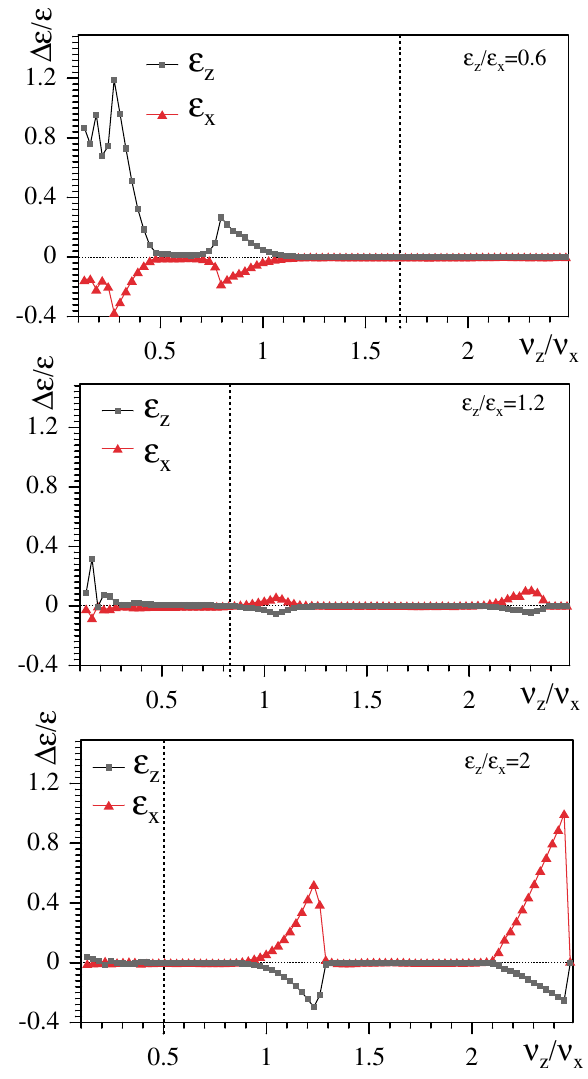
FIG. 9. (Color) Simulation results for WB beams, with (cid:3) 0 : 5 and (cid:19) (cid:3) 0 : 6 , 1.2, and 2 as functions of the =(cid:10) =(cid:19) (cid:10) x z x 0 x tune ratio (dashed lines